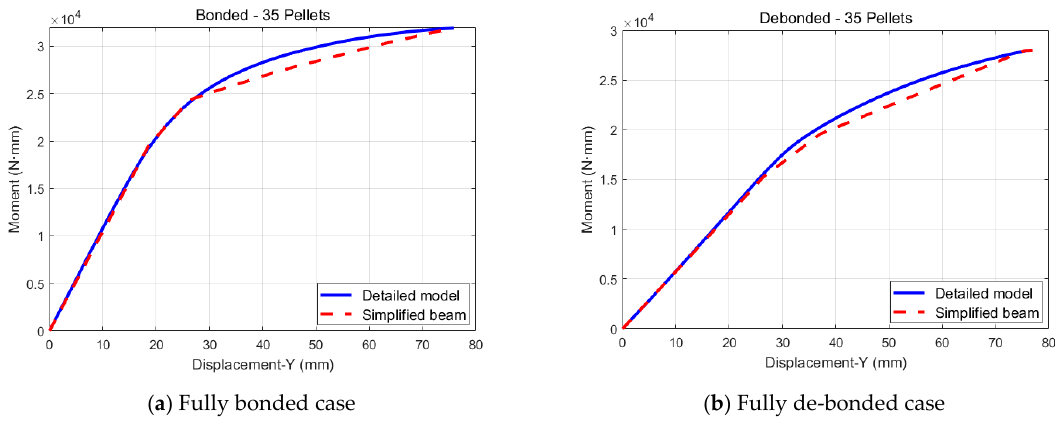
Table 4. Results of the beam model parameter calibration.